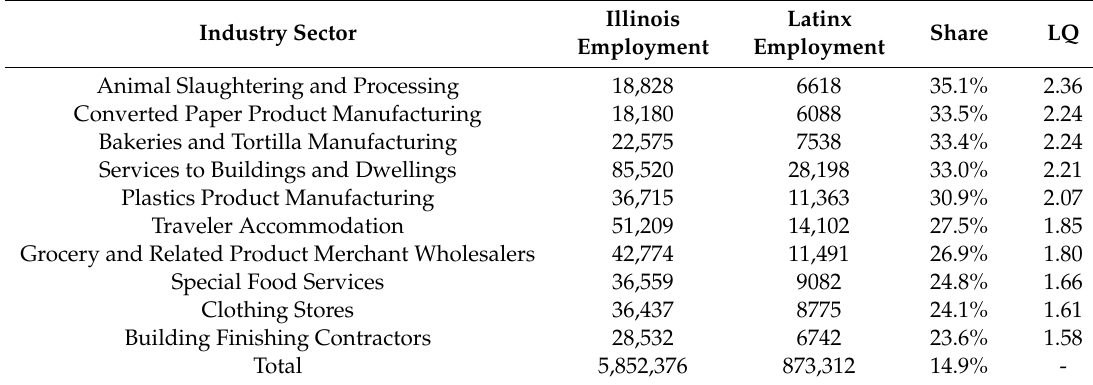
Table 2. Industries with Highest Concentration of Latinx.